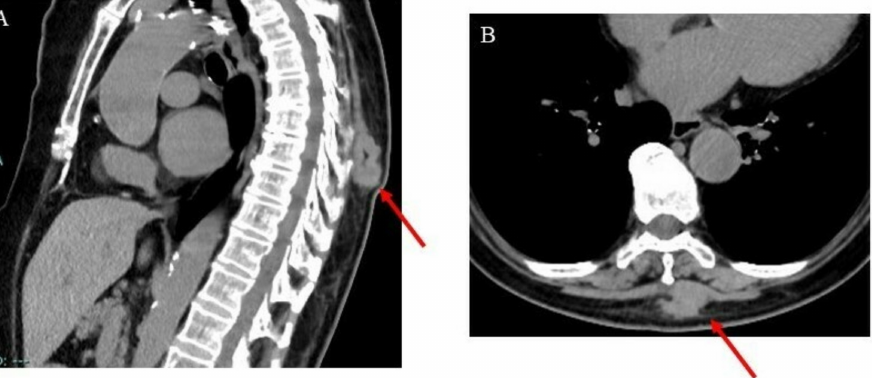
Figure 1. Images of the intrinsic back musculature of a 78-year-old female patient: ( A ) sagittal computed tomography (CT) image; ( B ) axial CT image.